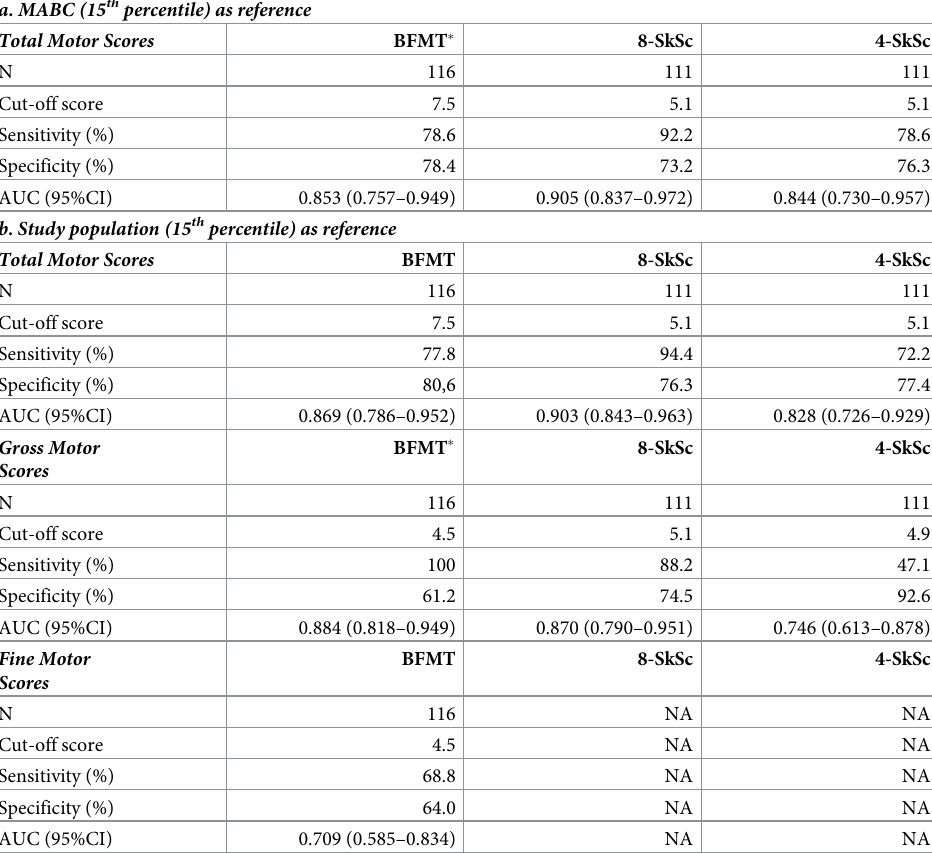
Table 4. AUC, sensitivity, specificity at optimal cut-off values of the BFMT, the 8- and 4-SkSc, using the total motor (TM) scores using the MABC as reference, with the 15 th percentile in the reference population (a)[31], and using the TM, gross motor (GM) and fine motor (FM) scores, using the MABC as reference, with the 15 th percen- tile of the study population (b). a . MABC (15 th percentile) as